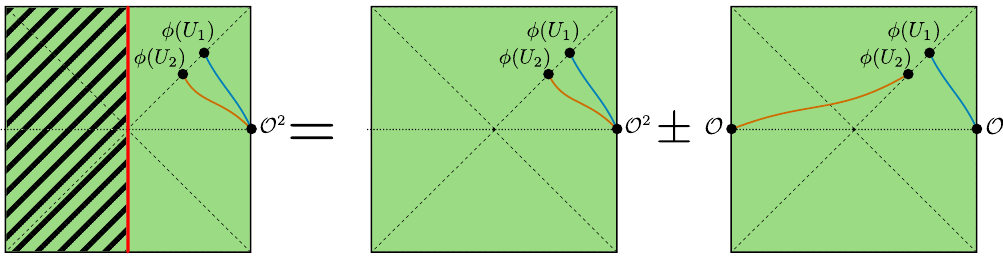
Figure 5 . The point-split correlation function in the B-State black hole can be expressed as a sum/difference of a correlation functions in the BTZ background. The blue corresponds to a retarded Green’s function, while the orange corresponds to a Feynman’s Green’s function. The first contribution on the right side does not contribute to the integral of the stress tensor on the